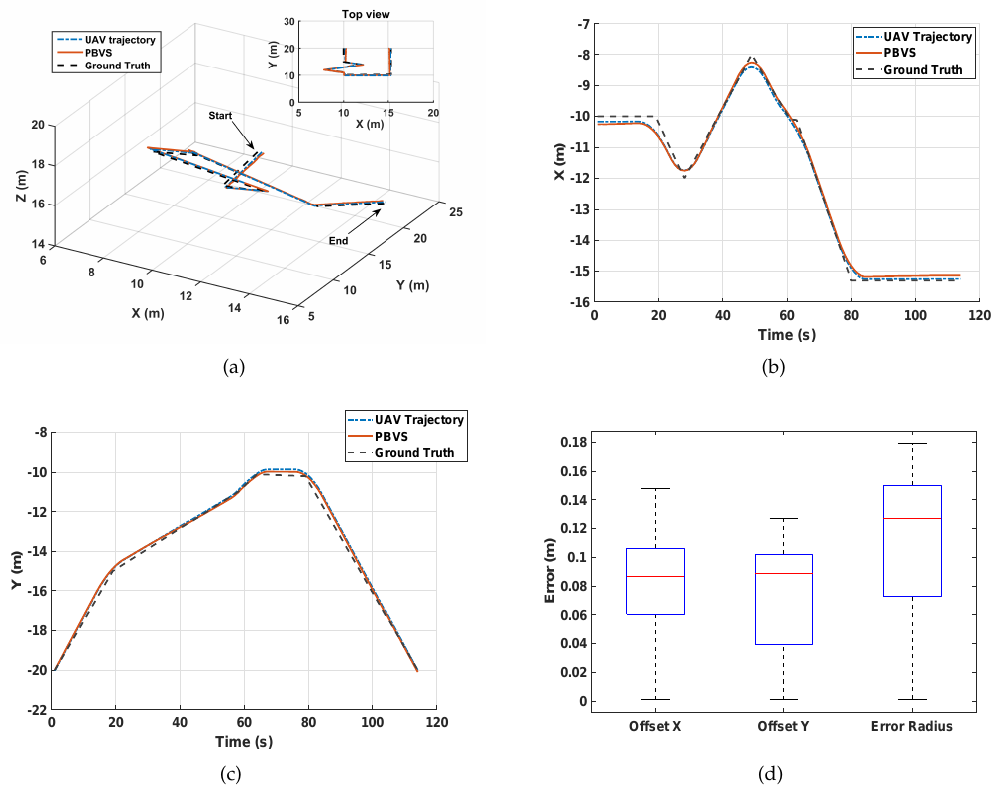
Figure 10. The flight simulation: ( a ) 3D trajectory of UAV; ( b ) the localization results in the X coordinate; ( c ) the localization results in the Y coordinate; ( d ) the trajectory